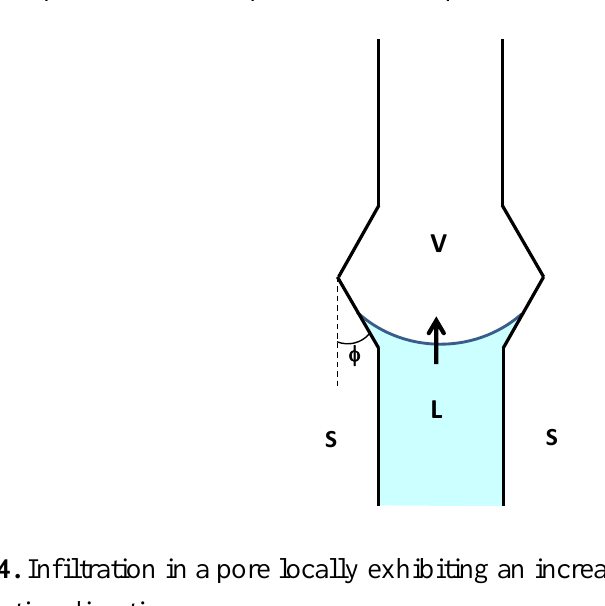
Figure 13. Schematic presentation of pore infiltration by a liquid in non-reactive ( a , b ) and reactive ( c , d ) systems. In case ( c ), the infiltration of a non-wettable solid S is assisted by the formation of a wettable reaction product layer (example: Si/porous graphite). In case ( d ), the infiltration of a wettable solid is hindered by the presence of a non-wettable layer covering the pore walls (example: Si/oxidised porous Si 3 N 4 ).